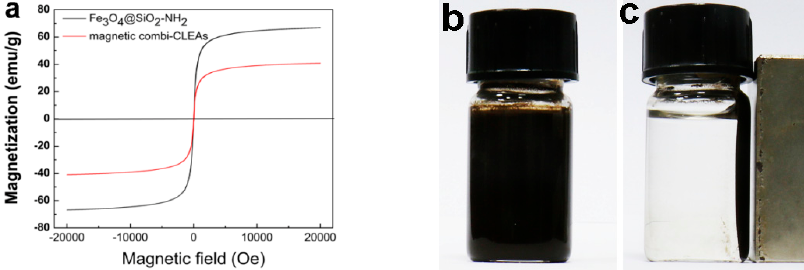
Figure 3. ( a ) Magnetic hysteresis curves of Fe 3 O 4 @SiO 2 -NH 2 and magnetic combi-CLEAs, ( b ) PBS-dispersivity of the magnetic combi-CLEAs and ( c ) the collection of the magnetic combi-CLEAs by an external magnetic field.